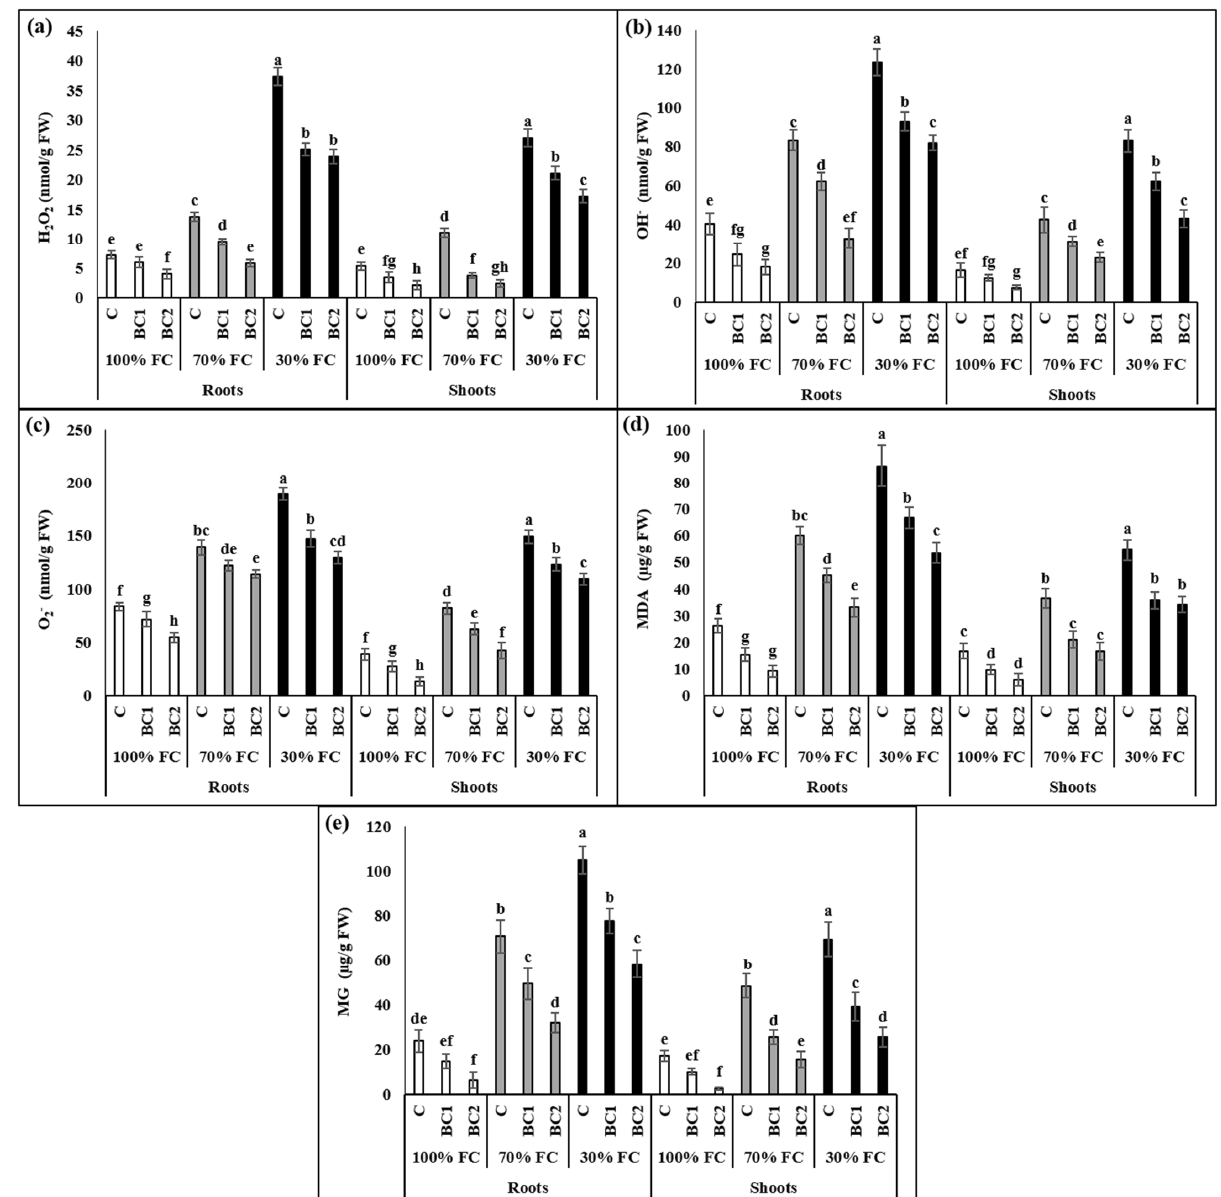
Figure 2. Reduction in the reactive species levels by biochar amendment in drought-stressed L. fusca plants. ( a ): hydrogen peroxide (H 2 O 2 ), ( b ): hydroxyl ion (OH − ), ( c ): superoxide ion (O 2 − ), ( d ): malonaldehyde (MDA), ( e ): methylglyoxal (MG). In addition, FC and BC represent field capacity and biochar, respectively. The values marked with different letters are significantly different from each other at p ≤ 0.05 levels in each parameter (ANOVA) followed by least significant difference (LSD) test. Similarly to roots, the shoots of L. fusca plants experienced an abrupt ampli fi cation in the H 2 O 2 , OH − , O 2 − , MDA, and MG levels a ft er drought stress, which was shown by the 2-, 2.6-, 2.1-, 2.2-, 2.8-fold elevation following 70% FC, and 5-, 5-, 3.9-, 3.3-, and 4-fold en-